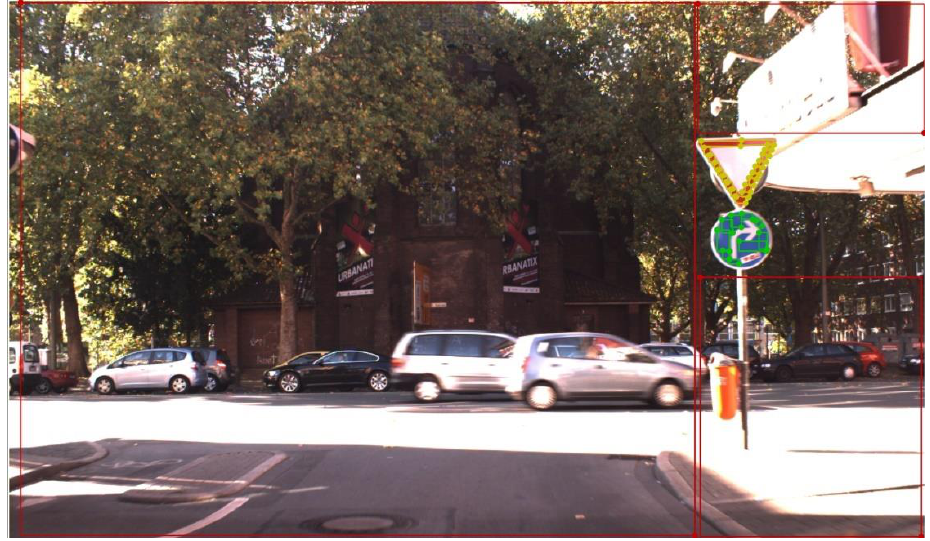
Figure 1. An annotated image ( c 1 — light green rectangles, c 2 — green rectangles, c 3 — red rectangles). Before training, all of the collected pixels were converted from the RGB color space into other color representations for use as feature vectors. Formally, an f rgb ( x , y ) pixel is represented with an f x , y vector, where f i is the i -th feature: